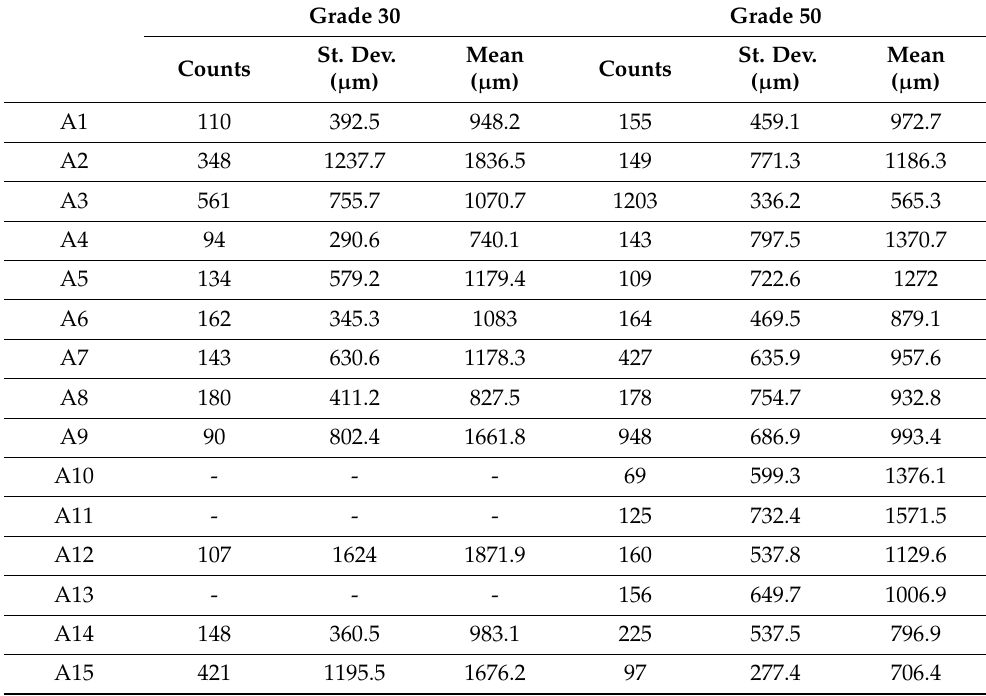
Table A9. Mean Cell’s Feret diameter ( d C ) of CFF samples of Grade 30 and Grade 50 from supplier